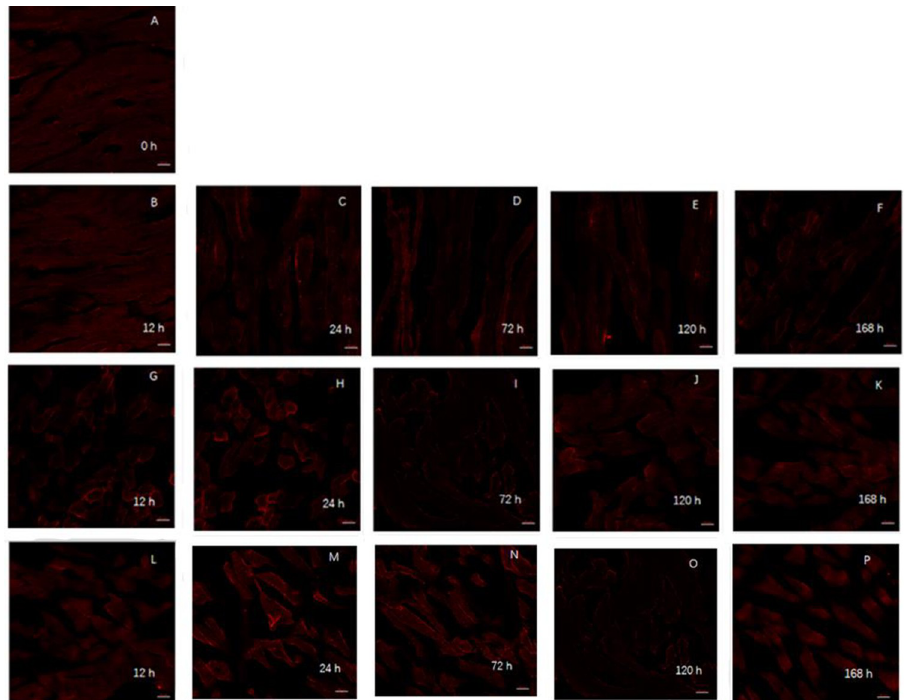
Fig 3. Observation of mitochondrial morphology distribution in yak muscle during postmortem maturation with laser confocal microscope. PGC1- α are marked by PGC1- α (1:100) in red. A-F: at 0, 12, 24, 72, 120 and 168 h in the NAD + treatment group; G-K: at 12, 24, 72, 120 and 168 h in the blank control group; L-P: at 12, 24, 72, 120 and 168 h in NADH treatment group.